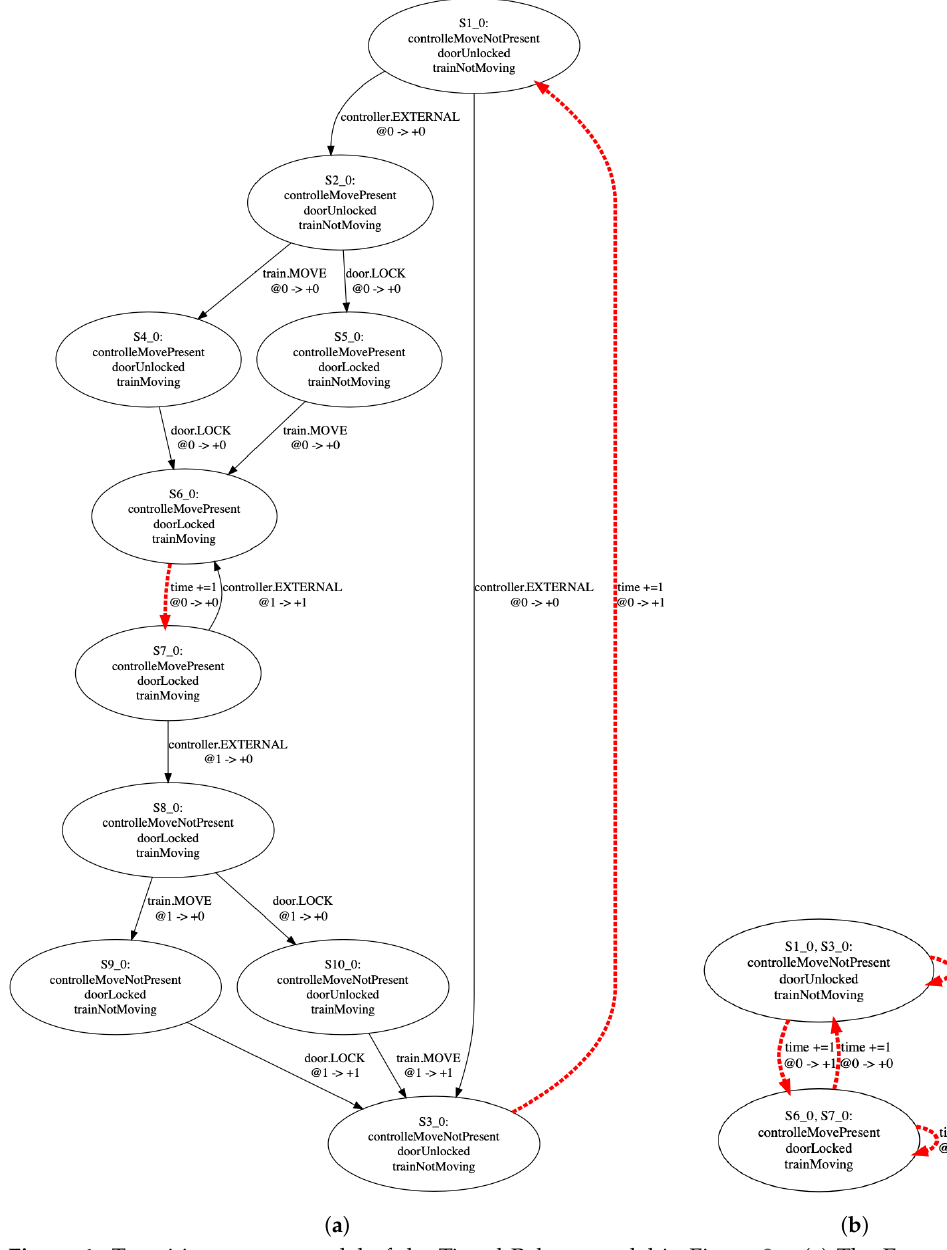
Figure 4. Transition system model of the Timed Rebeca model in Figure 2c. ( a ) The Event-based transition system model which is generated by Afra [10]. ( b ) The Logical-time-based semantics of the